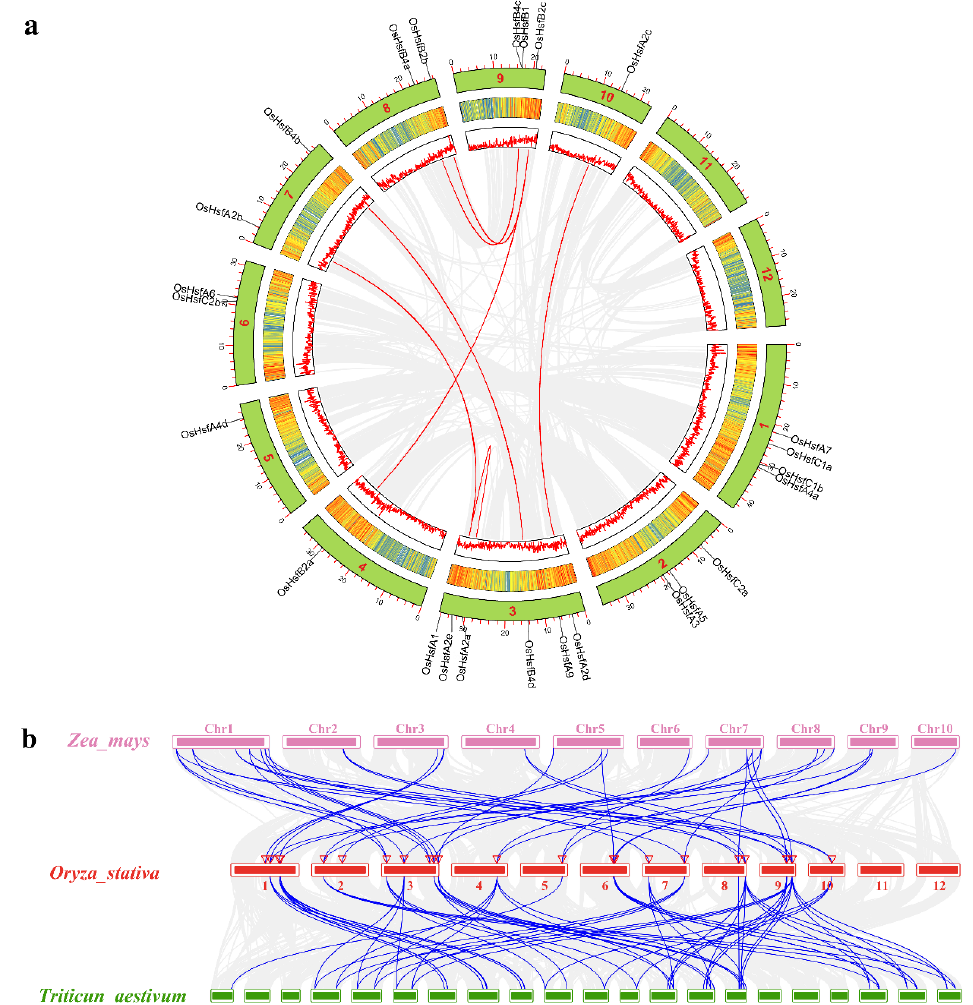
Figure 3. Synteny analysis of OsHsf genes. ( a ) Interchromosomal relationships of OsHsf genes. Grey lines indicate all synteny blocks of rice, and red lines indicate links beween OsHsf syntenic genes; ( b ) Synteny analysis of OsHsf genes between maize, rice, and wheat. Red triangles indicate the positions of OsHsfs . All collinearity blocks and collinearity blocks of Hsf gene pairs within rice, maize, and wheat are indicated by grey lines and blue lines, respectively.